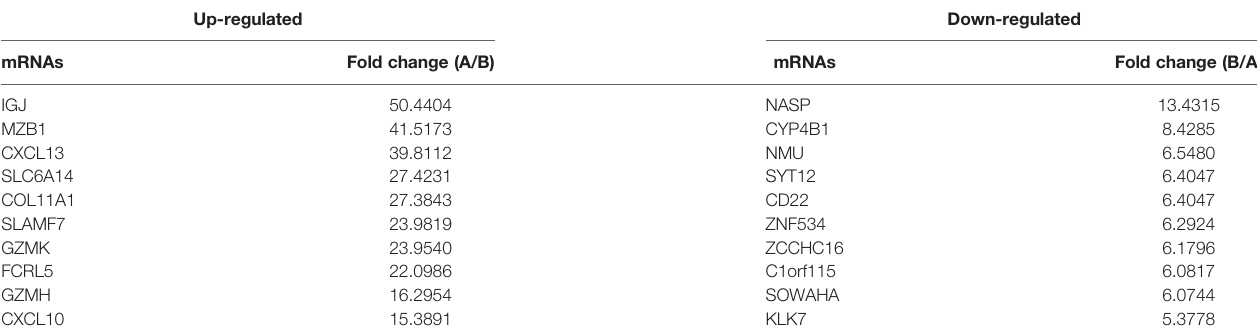
TABLE 2 | Deregulated mRNAs detected in PTC/HT(+) and PTC/HT(-).